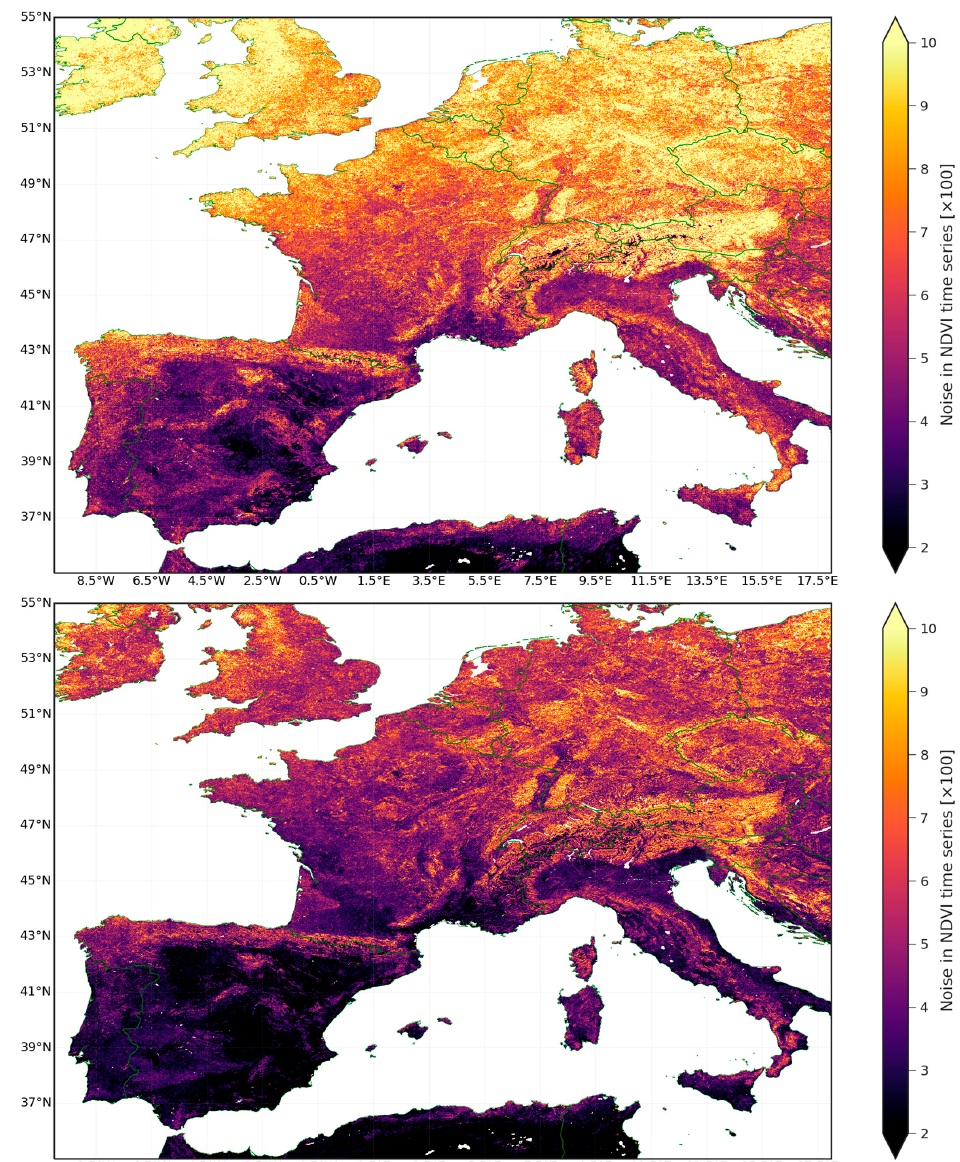
Figure 8. Statistical noise in MVC NDVI ( top-panel ) and BRDF-adjusted NDVI ( bottom-panel ) Time-Series for a subregion in Western Europe. The noise levels and country borders are color coded in the same fashion as in Figure